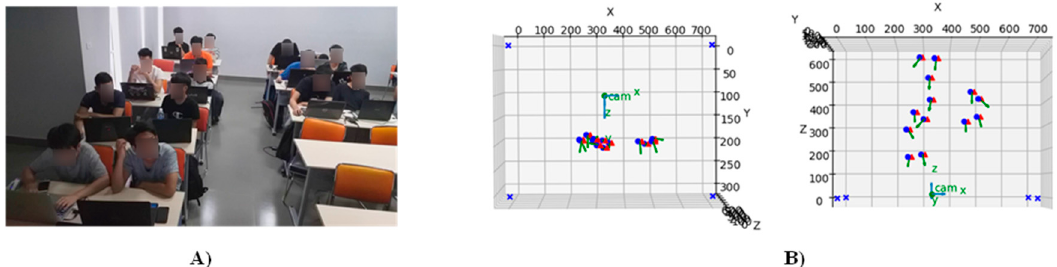
Figure 3. ( A ) The frame acquired from the camera. ( B ) Estimated locations of each student in the sample. The image on the left side illustrates student points in the 3D coordinate system with the perspective from the board. Likewise, the right one represents perspective from top to bottom. The blue x’s represent four room corner points, which belong to the space containing the board. Pairs of S 1 and 𝑆 (cid:2870) points are denoted in red and blue dots respectively.